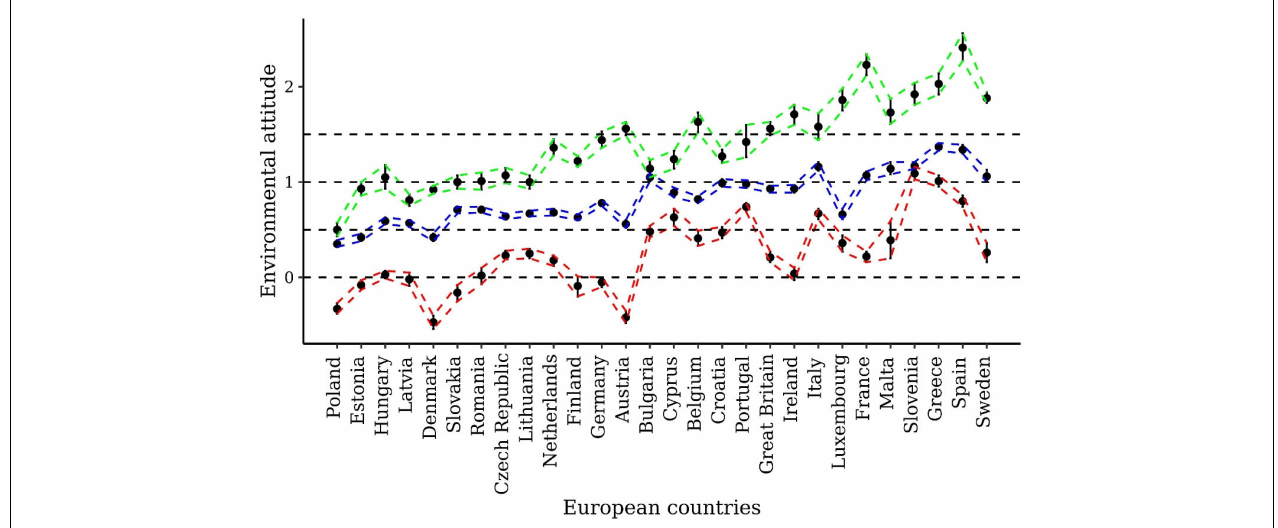
FIGURE 3 | Average environmental attitudes of people with a high, moderate, or low green consumption performance across 28 European countries. Countries are ordered according to their average environmental attitudes (see Figure 2 ). Dashed lines connect the 90% credible intervals of the three distinct green-consumption